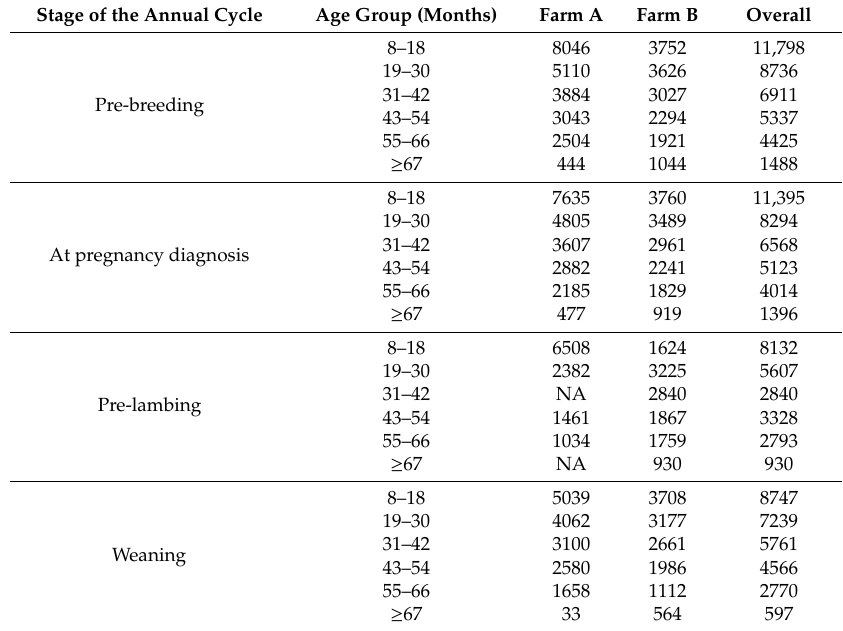
Table A1. The number of ewes by age group (8–18 months, 19–30, 31–42, 43–54, 55–66 and ≥ 67), stage